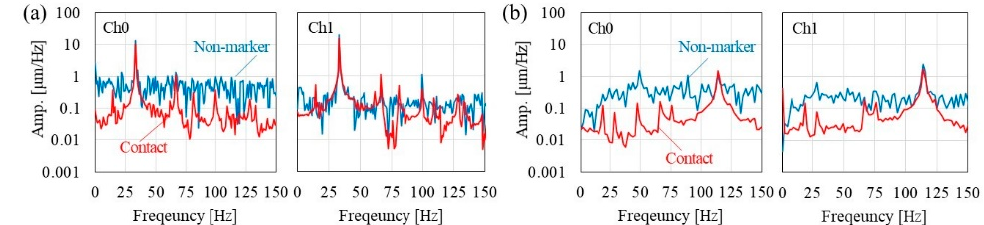
Figure 13. Measured frequency spectra; ( a ) 35 Hz excitation at the midspan, ( b ) 120 Hz excitation at